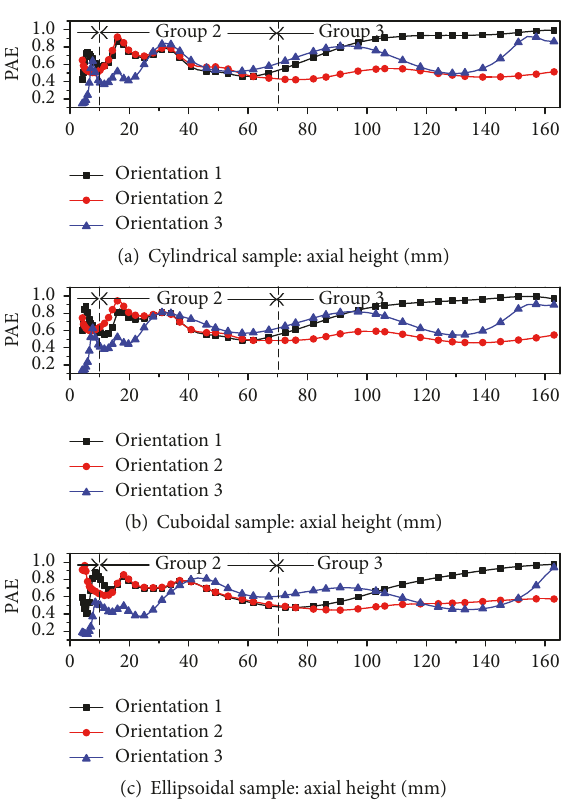
Figure 29: PAE of the same samples in different orientations.